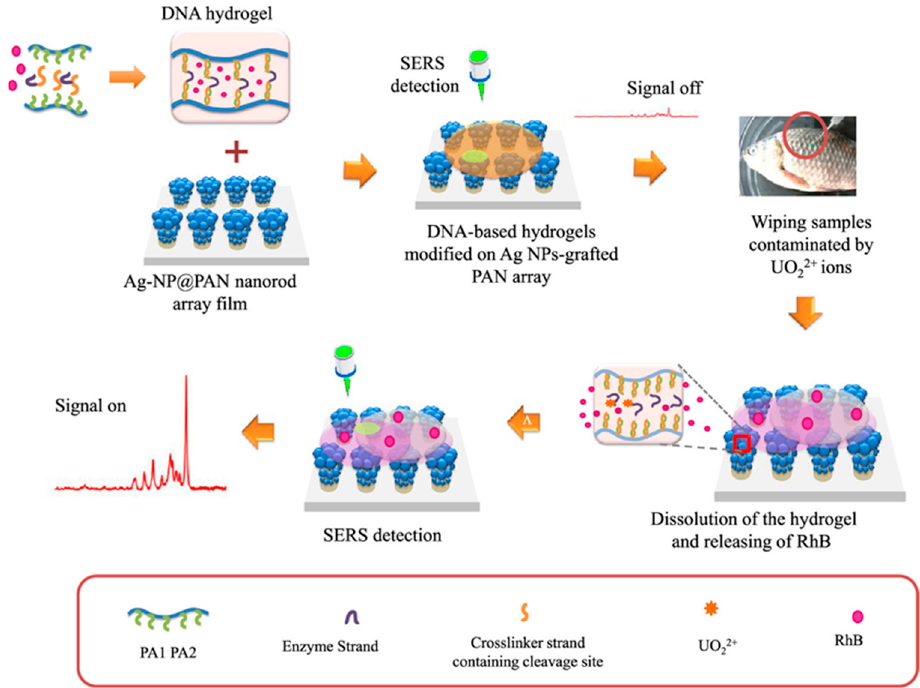
Figure 5. Schematic illustration of the DNA hydrogels coating to SERS substrate as a flexible biosensor for UO 22+ detection. Reproduced with permission from Xuan He, Langmuir; published by American Chemical Society, 2020.